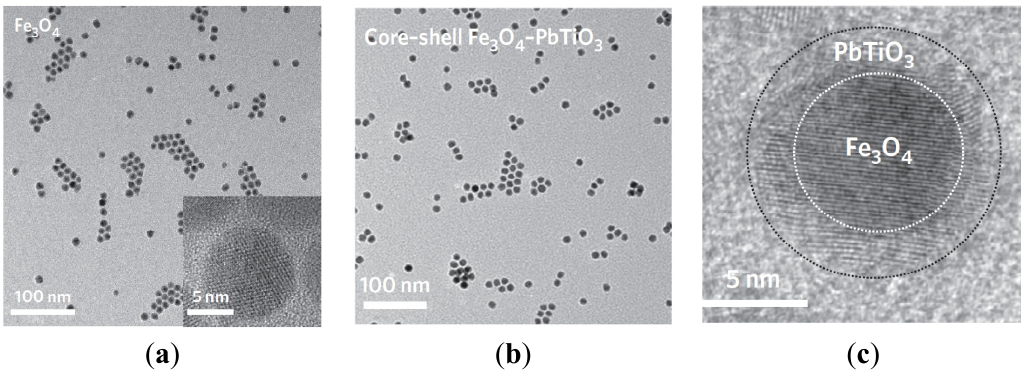
Figure 19. ( a ) Representative TEM images for Fe O ) = 10.1 ± 0.5 nm; ( b ) TEM; and ( c ) HRTEM images of PAA- b -PS templates, D (Fe 3 4 Fe O -PbTiO core-shell NPs formed with the star-like triblock copolymers nanoreactors. 3 4 3 Reprinted with permission from [42]. Copyright 2013 Macmillan Publishers Limited.